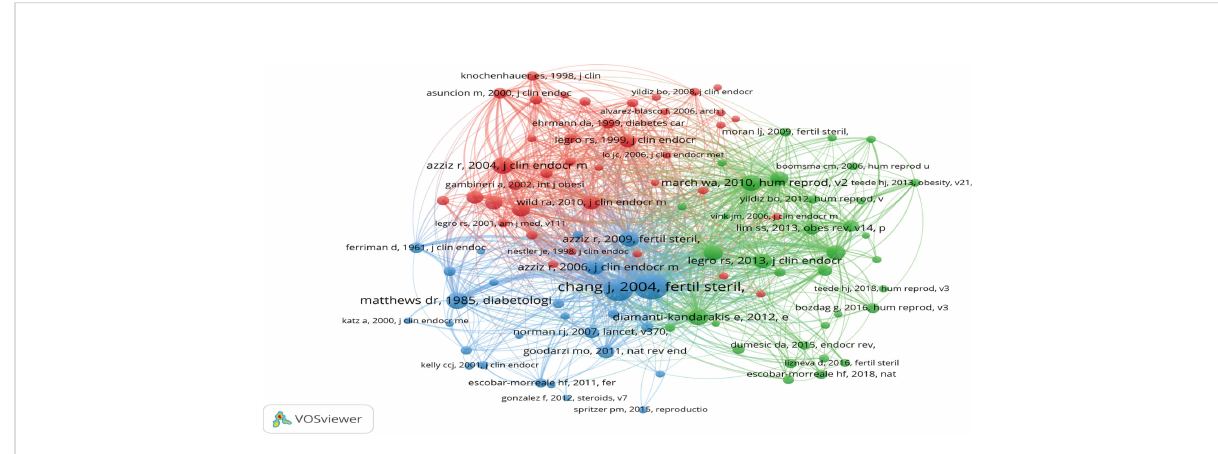
FIGURE 7 Network map of co-citation references.